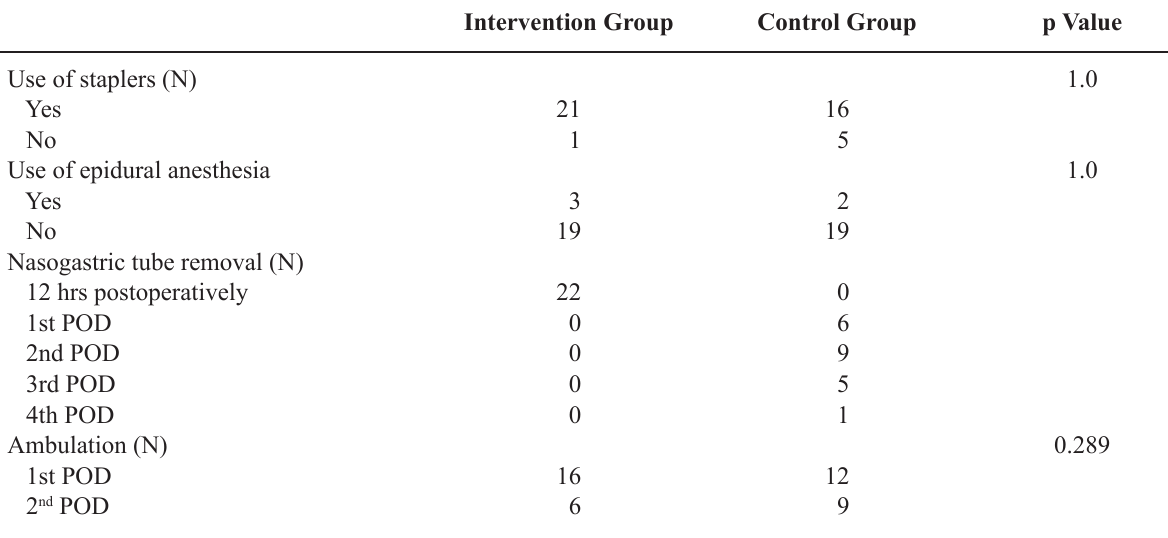
Table 2 – Perioperative care plan (POD = postoperative